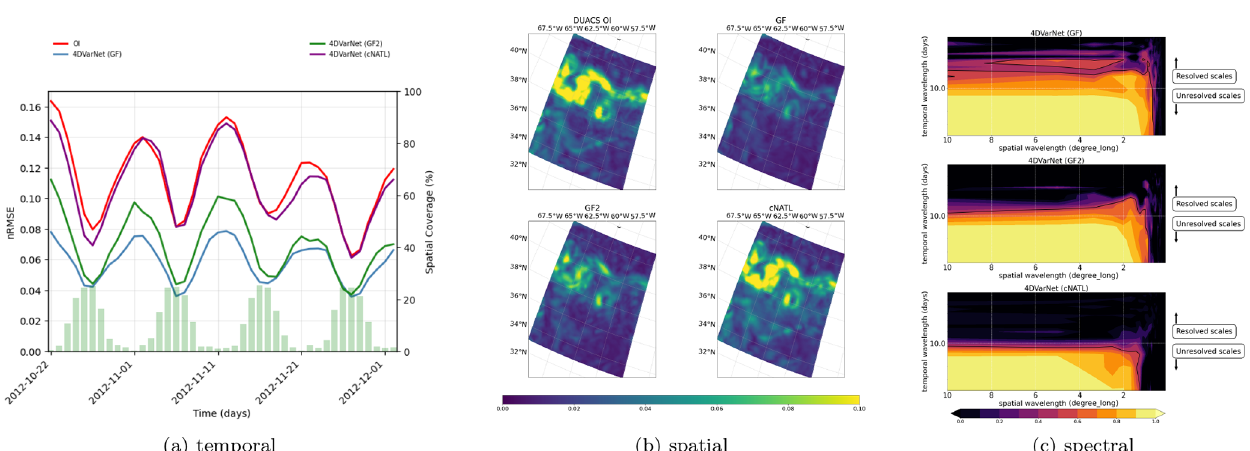
Figure B1. 4DVarNet generalization capabilities (GULFSTREAM), with the spatial, temporal, and spectral performance in the BOOST- SWOT DC evaluation period, based on the three different training domains of GULFSTREAM, GULFSTREAM2, and